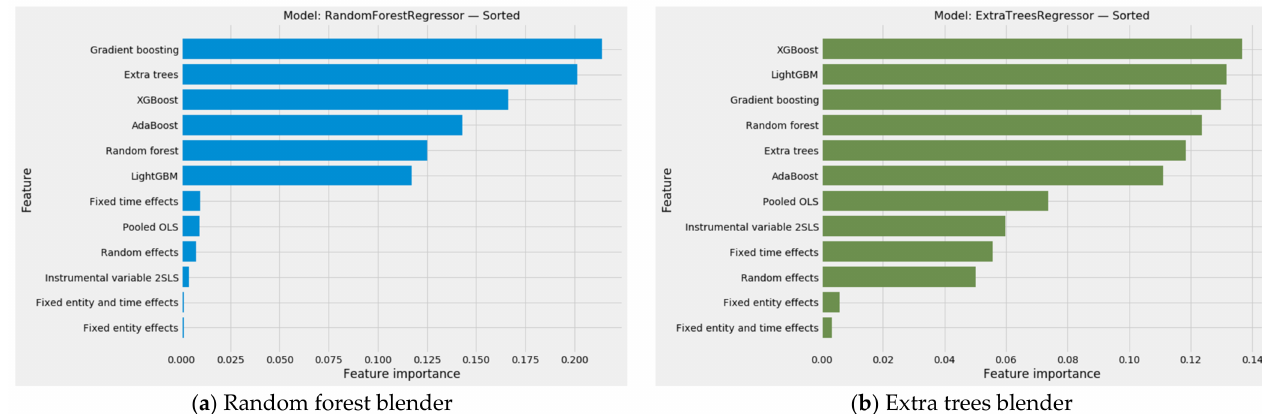
Figure 6. Feature importances within two stacking blenders: ( a ) random forests; ( b ) extra